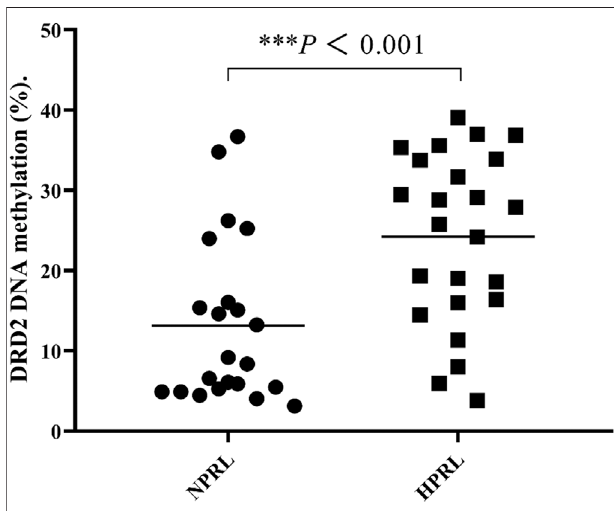
FIGURE2| ComparisonsofDRD2DNAmethylation(%)betweenHPRL and NPRL subjects. Each bar represents the mean ± standard error (*** p < 0.001 versus NPRL).